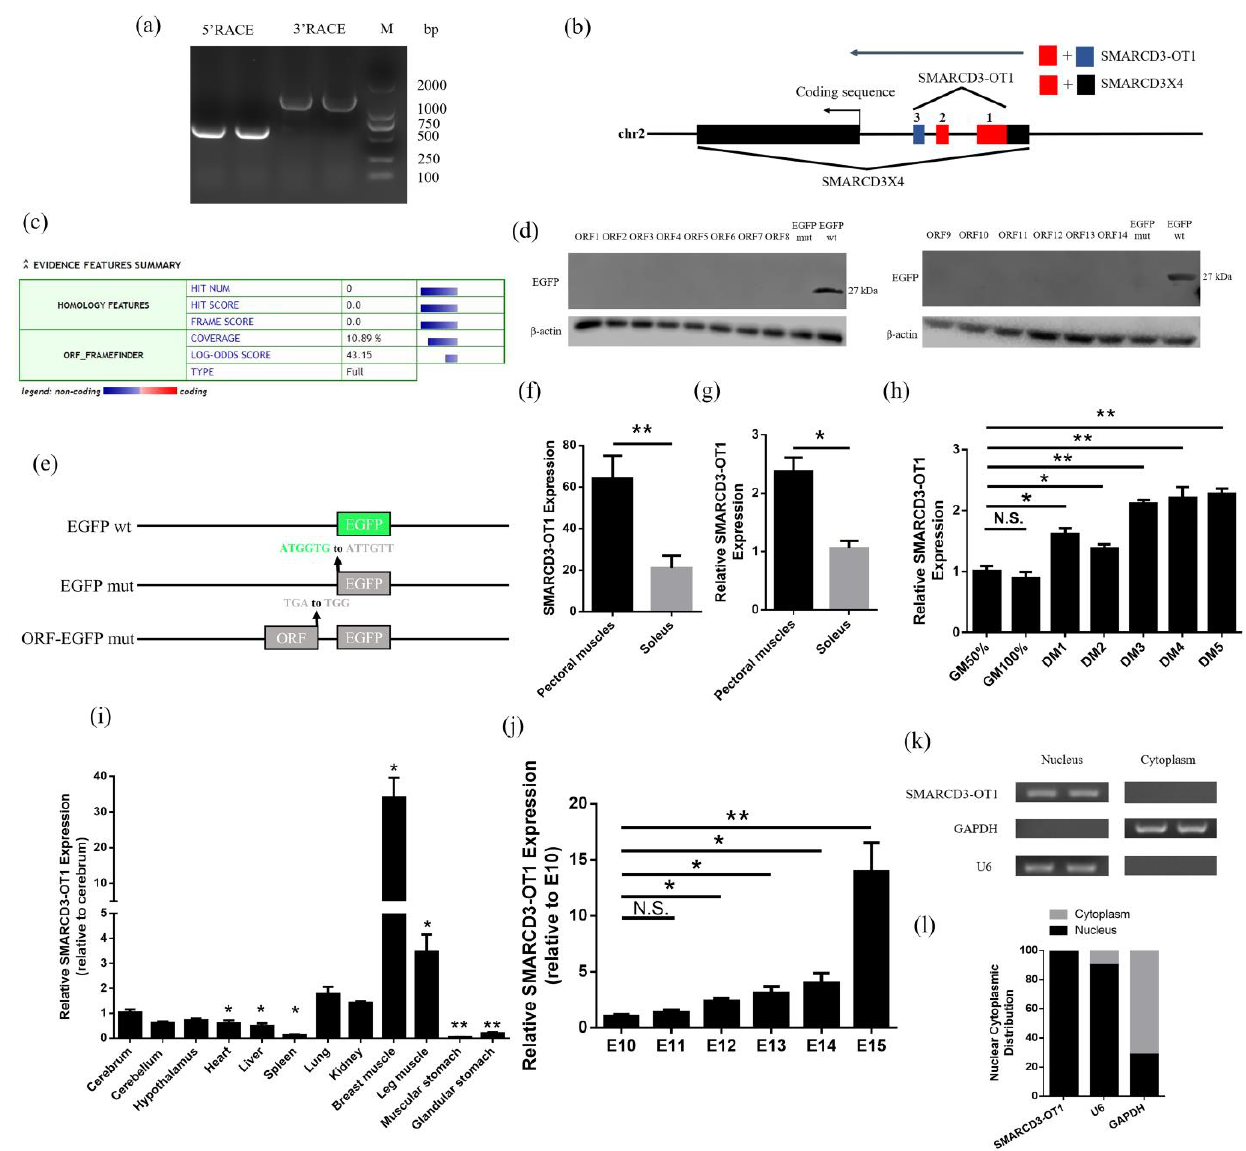
Figure 1. Identification of lncRNA SMARCD3-OT1 and the expression pattern of SMARCD3-OT1 . ( a ) Results of SMARCD3-OT1 5′ RACE and 3′RACE. ( b ) Schematic image of the locations for SMARCD3-OT1 (red and blue) and SMARCD3X4 (red and black). Arrows represent the direction of transcription. ( c ) Prediction of the SMARCD3-OT1 protein-coding ability. ( d ) Western blotting with anti-EGFP. ( e ) Diagram of the EGFP fusion construct vectors used for transfection. The initiation codon ATGGTG of the EGFP (EGFP wt) gene is mutated to ATTGTT (EGFP mut), and the termination codon TGA of ORFs is mutated to TGG. ( f , g ) RNA sequencing result of SMARCD3-OT1 and further qRT-PCR verification. ( h ) Expression levels of SMARCD3-OT1 in CPMs cultured in growth medium at 50% and 100% cell confluency (50%GM and 100%GM) and differentiation medium from 1 to 5 days (DM1 to DM5) ( n = 6). ( i ) Tissue expression profiles of SMARCD3-OT1 in 7-week-old chickens ( n = 6). ( j ) Expression levels of SMARCD3-OT1 from E10 to E15 ( n = 6). ( k , l ) Distribution of SMARCD3-OT1 in the cytoplasm and nuclei of CPMs was determined by PCR and qRT-PCR. Data are presented as